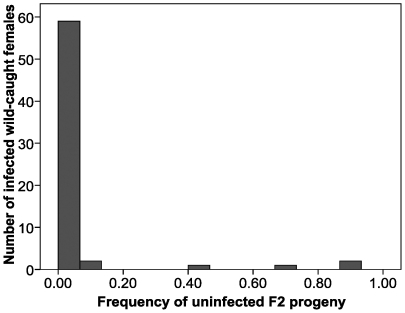
Histogram showing the number of infected females from nature that yielded different frequencies of uninfected F2 progeny after mating to W88 males in the lab.